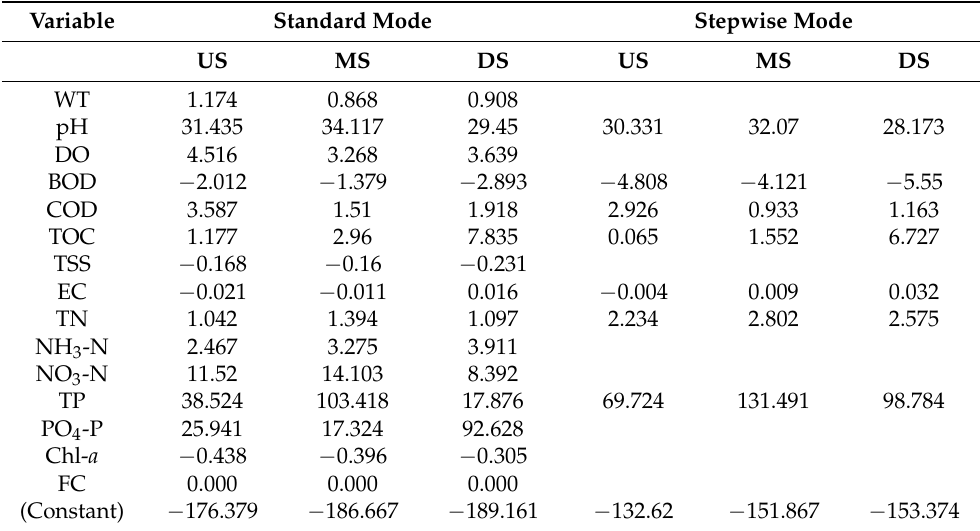
Table 7. Discriminant functions to determine spatial changes (Fisher’s linear discriminant functions).